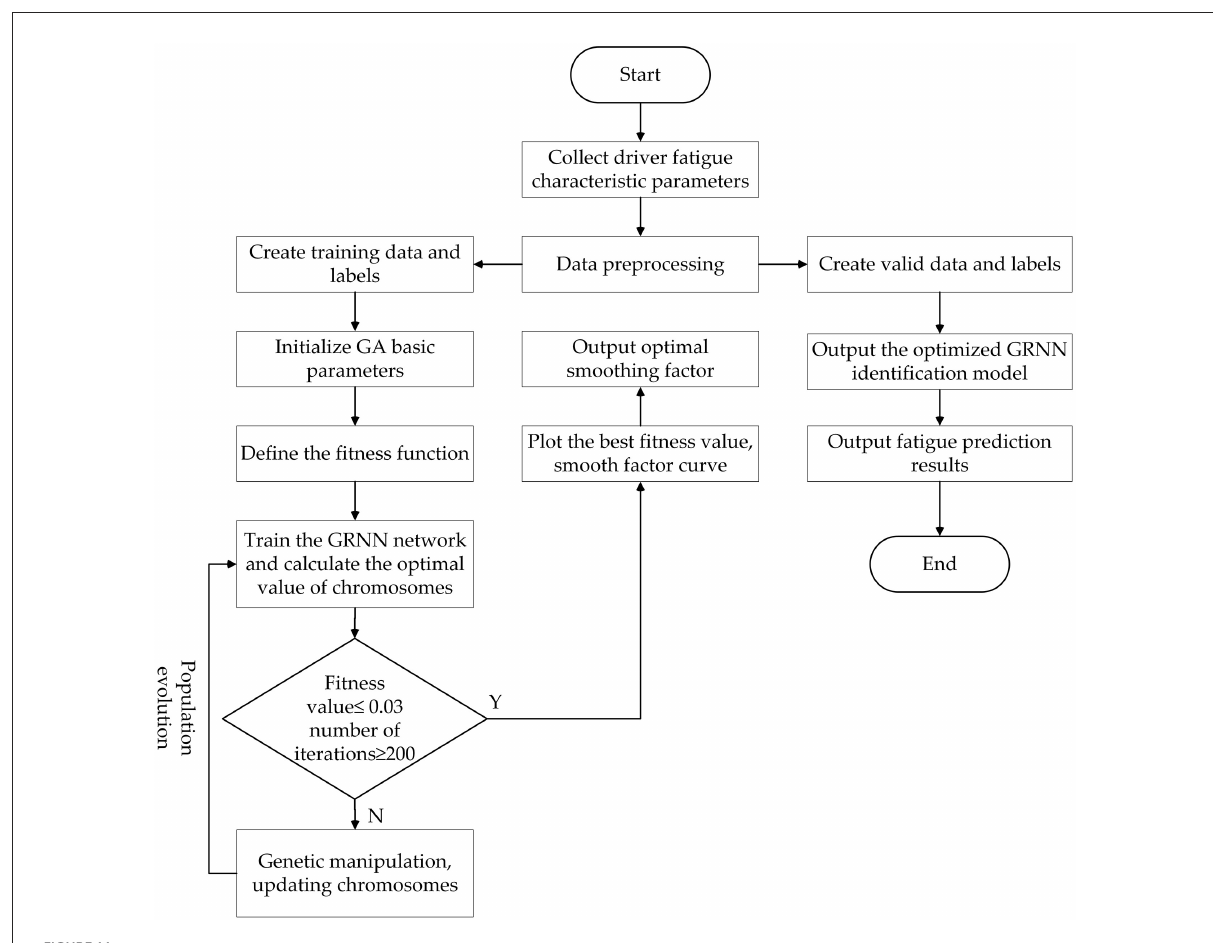
FIGURE11 Training flowchart of GA optimizes GRNN